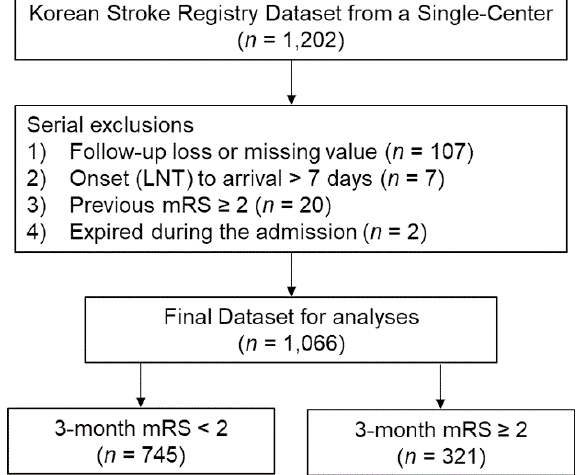
Figure 1. Flow chart of patient inclusion and exclusion. LNT, last normal time; mRS, modified Ran- kin Scale.